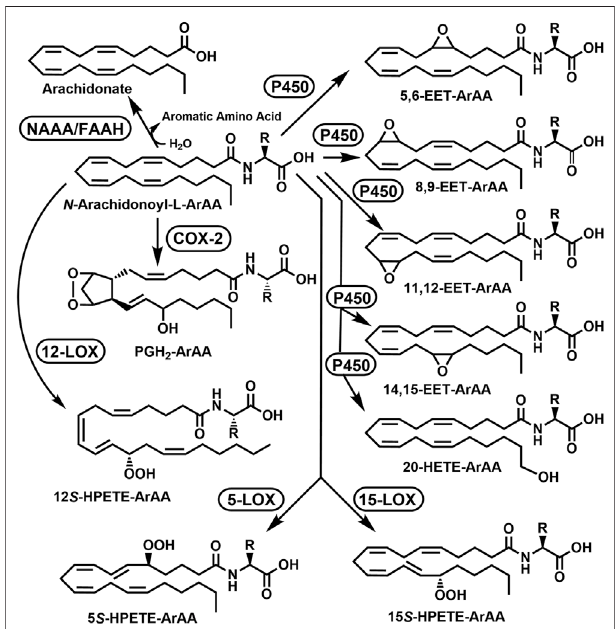
FIGURE 3 | Putative Acyl Group Oxidation and Hydrolytic Degradation of the N-Arachidonoyl Aromatic Amino Acids (ArAAs). The possible metabolites are 5,6-EET-ArAA, N -5,6-epoxyeicosatrienoyl-ArAA; 8,9-EET- ArAA, N -8,9-epoxyeicosatrienoyl-ArAA; 11,12-EET-ArAA, N -11,12- epoxyeicosatrienoyl-ArAA; 14,15-EET-ArAA, N -14,15-epoxyeicosatrienoyl- ArAA; 20-HETE-ArAA, N -20-hydroxyeicosatetraenoyl-ArAA; 5 S -HPETE- ArAA, N -(5 S -hydroperoxy)-eicosatetraenoyl-ArAA; 12 S -HPETE-ArAA, N - (12 S -hydroperoxy)-eicosatetraenoyl-ArAA; 15 S -HPETE-ArAA, N - (15 S -hydroperoxy)-eicosatetraenoyl-ArAA; and PGH 2 -EA, prostaglandin E 2 - ArAA. The enzymes would be COX-2, cyclooxygenase-2; FAAH, fatty acid amidehydrolase;5-LOX, 5-lipoxygenase;12-LOX,12-lipoxygenase,15-LOX, 15-lipoxygenase, NAAA, N -acylethanolamine hydrolyzing acid amidase; and P450, cytochrome P450. The R-group represents the side-groups for the aromatic amino acids shown in Figure 1 . This fi gure is adapted from the modi fi cations of anandamide described in Rouzer and Marnett (2011) and Biringer (2021).